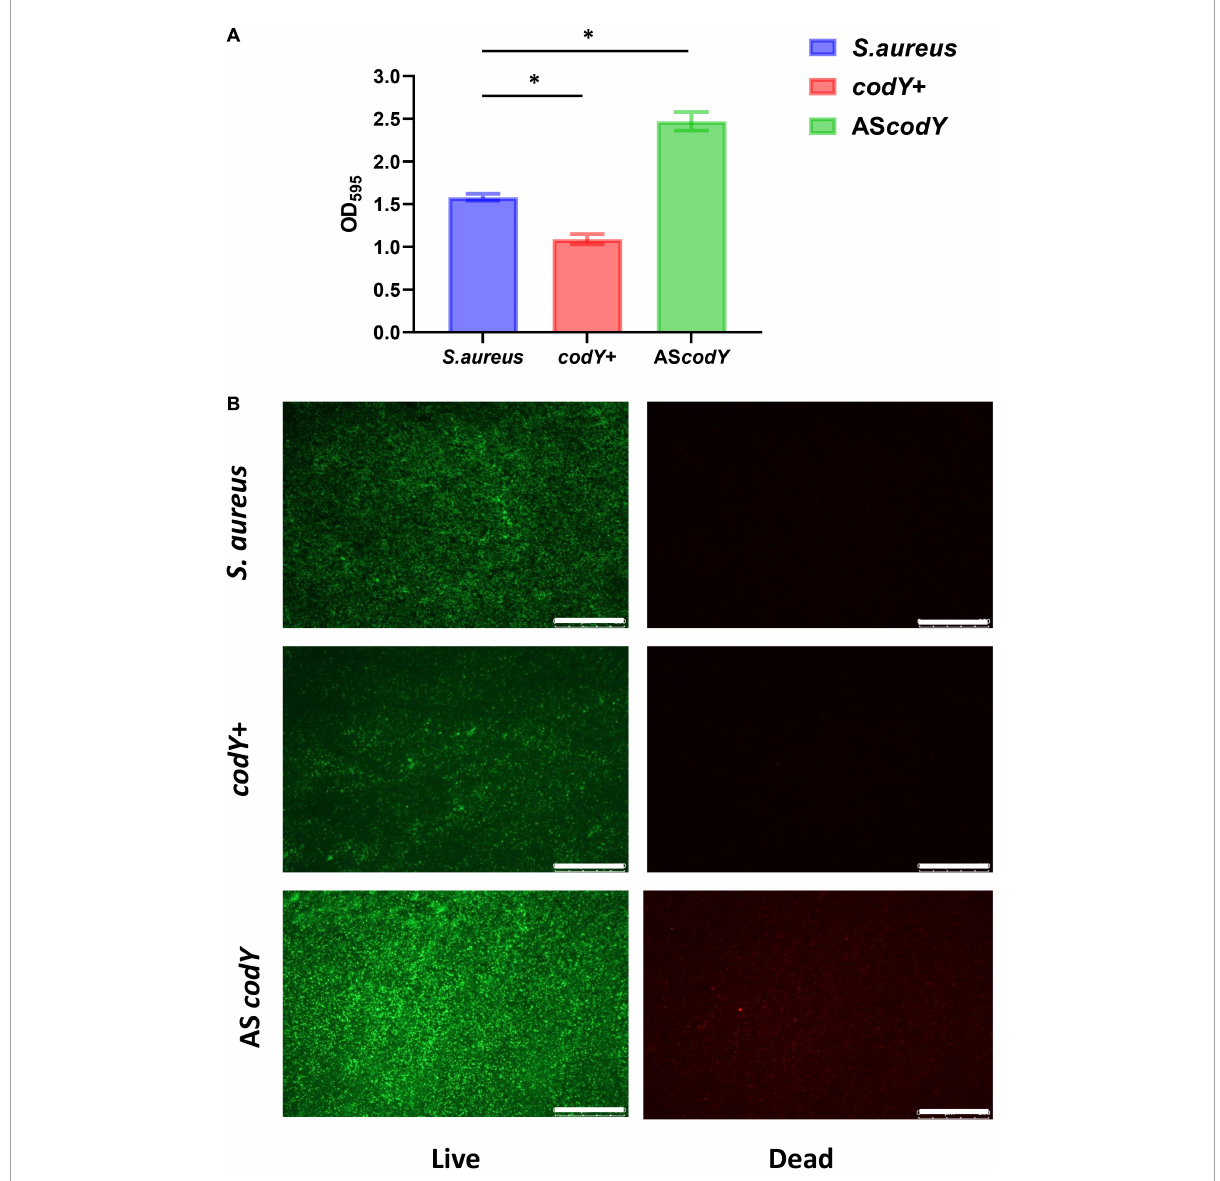
FIGURE5 CodY decreases the biomass of S. aureus biofilm . (A) Biomass of S. aureus , codY + and codY - mutant stains were quantified by crystal violet staining. Optical densities at 595 nm were measured ( n = 5, ∗ P < 0.05). (B) The CLSM observations of S. aureus , codY + and codY - mutant stains. Green, viable bacteria (SYTO 9); red, dead bacteria (PI); scale bars, 250 µ